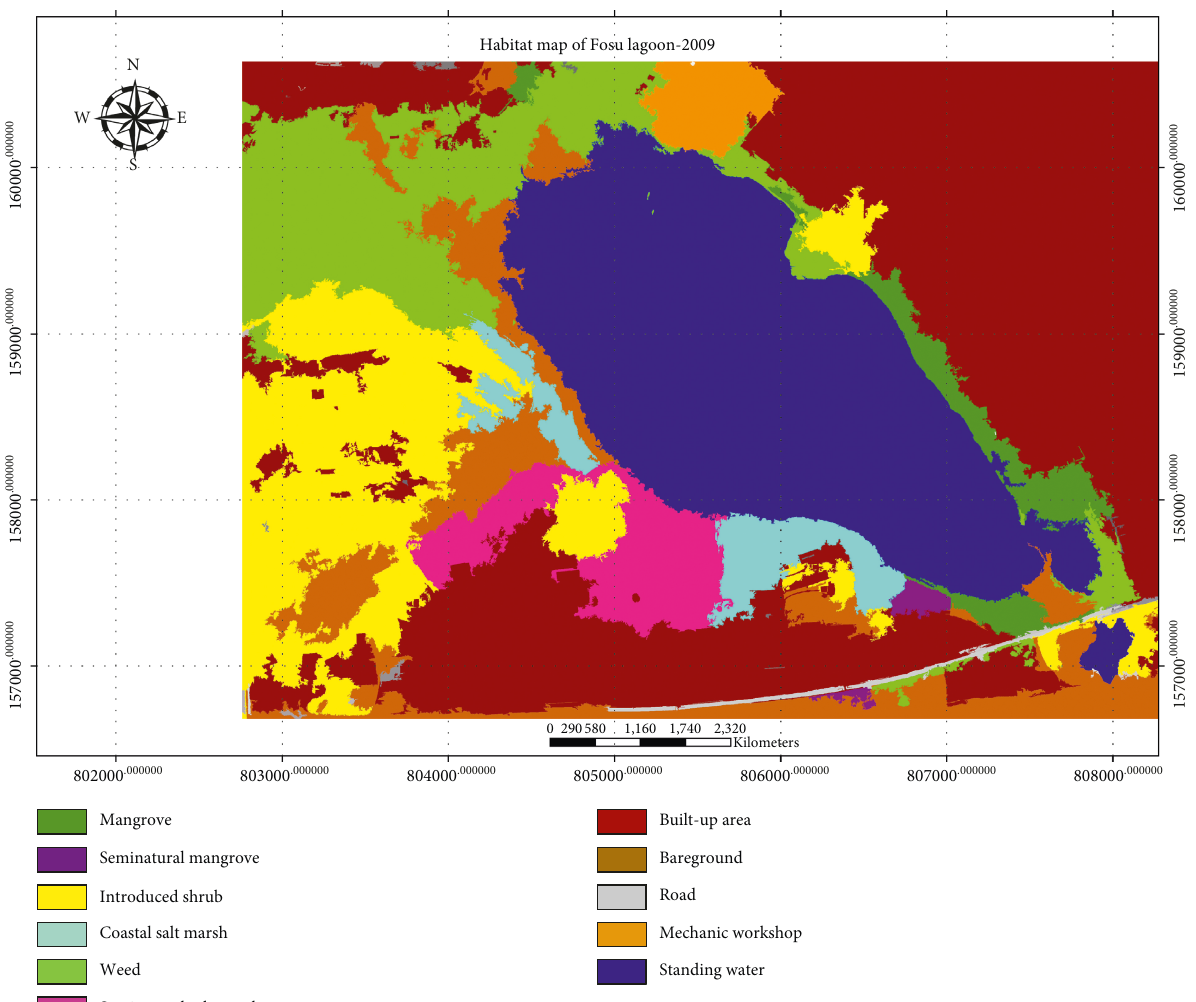
Figure 3: Habitat map of Fosu lagoon in